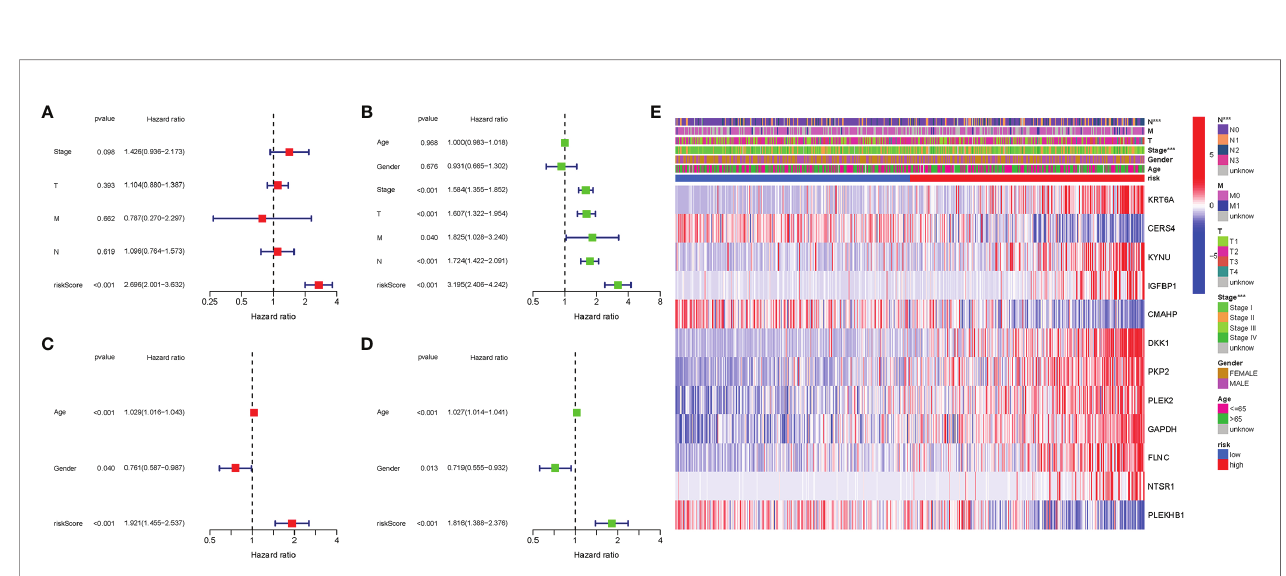
FIGURE 6 | Validation of the risk model in the GEO cohort. (A) The survival status for each patient (low-risk population: on the left side of the dotted line; high-risk population: on the right side of the dotted line). (B) Kaplan – Meier curves for the OS of patients in the high- and low-risk groups. (C) The AUC of the for the prediction of 1-, 2-, 3-year survival rate of LUAD. (D) PCA plot for LUADs based on the risk score. (E) t-SNE plot for LUADs based on the risk score.